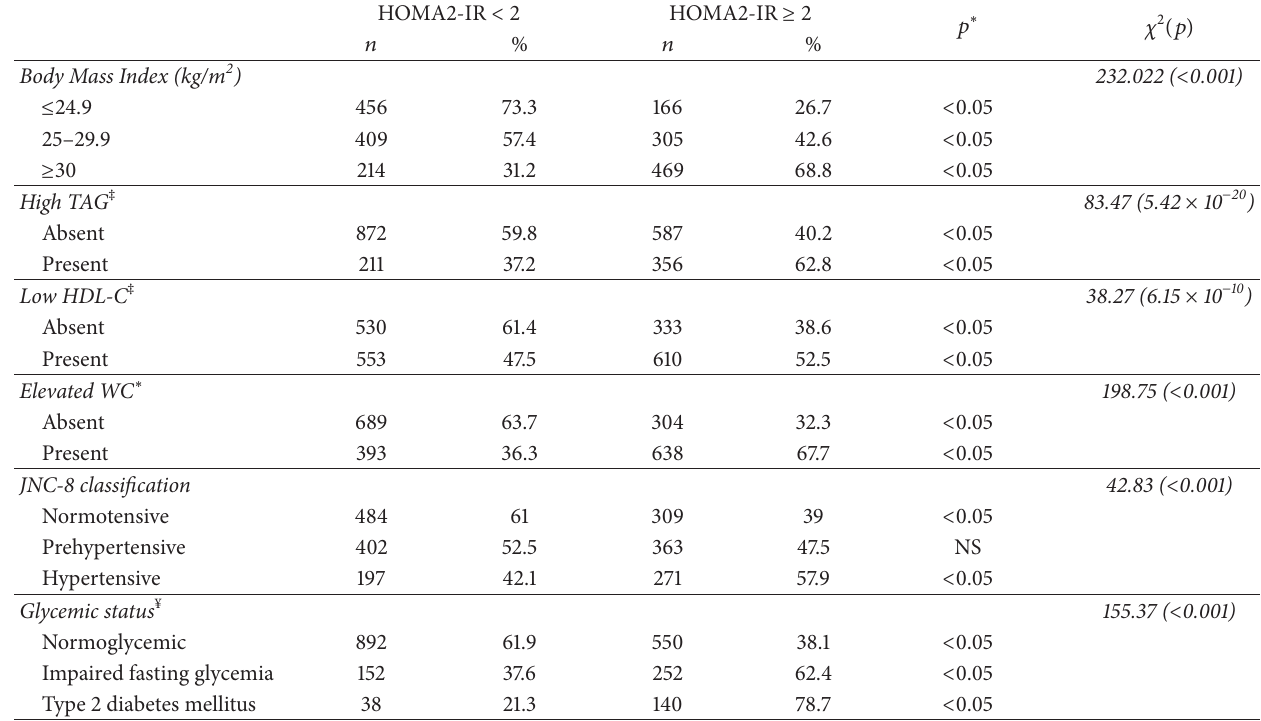
Table 6: Prevalence of insulin resistance in the general population by metabolic characteristics (Maracaibo, Venezuela, 2015).